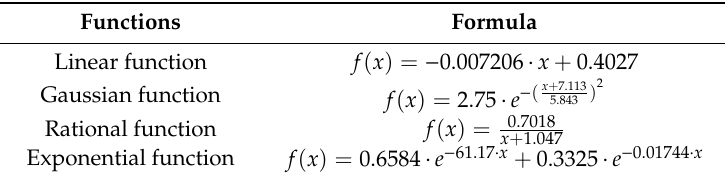
Table 2. List of Fitting formulas.